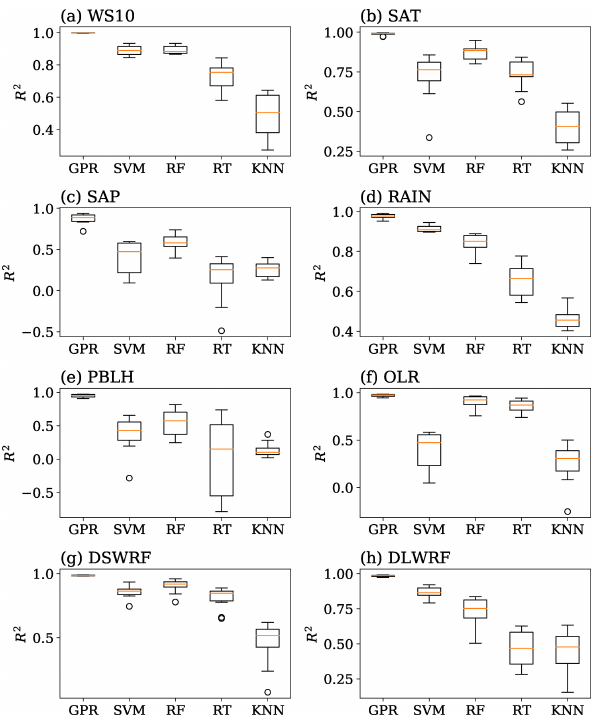
Figure 7. Cross-validation results of the surrogate models GPR, SVMs, RF, RT, and KNN for the meteorological variables consid- ered in the present study.